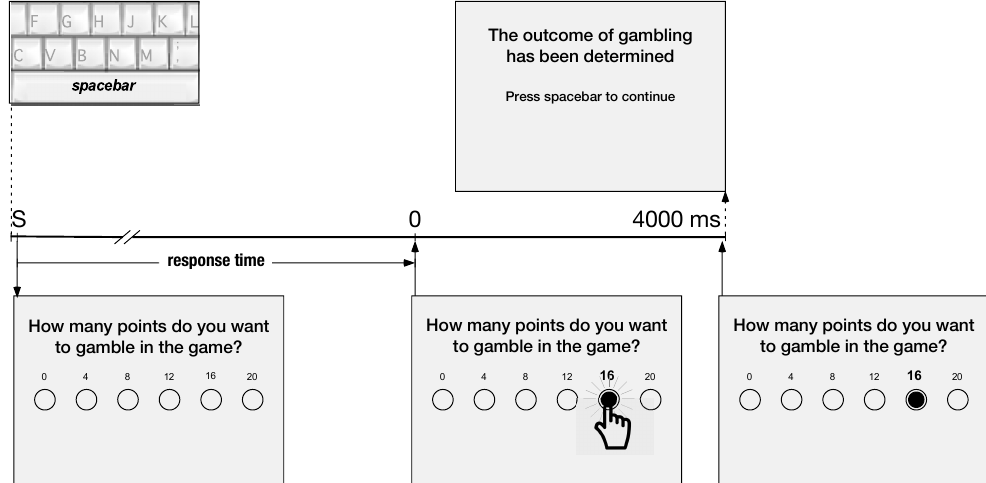
Figure 2. Probabilistic gambling task. A trial started when the participant pressed the spacebar (event S in the timeline), followed (20 milliseconds later) by a screen with a message request to select the gamble. This screen stayed on until a response was made by clicking on the selected value of gamble (event 0). The response time was determined by the interval between that message and the selection of gamble. This button click (event 0) was used as triggering event for the electrophysiological analysis. A fixed interval of 4000 ms followed until the end of the trial with the same screen and with the highlighted selected